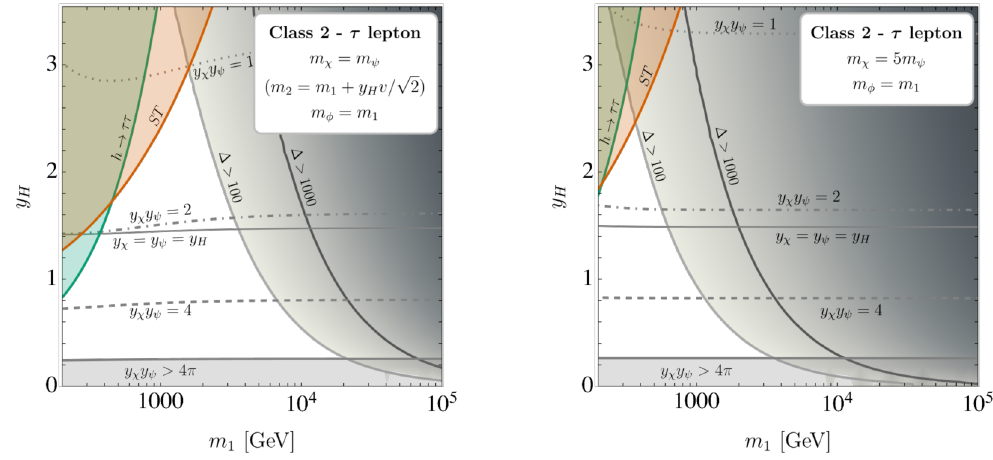
Figure 10. Theoretical (grey) and current 2 σ experimental constraints (coloured) on the Class 2 τ -lepton benchmark